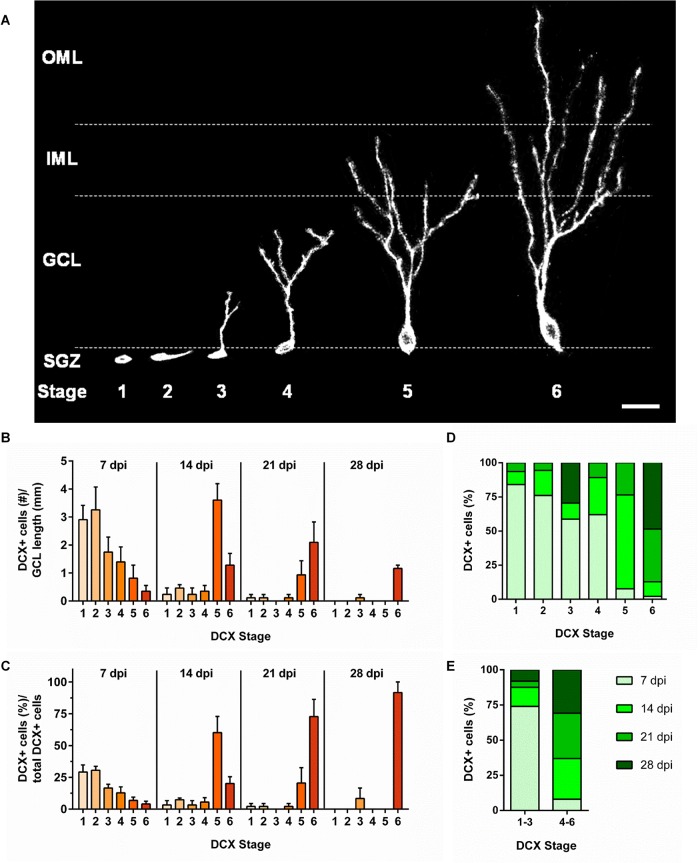
Structural maturation of DCX-expressing newborn DGCs is correlated with cell age.(A) DCX+ cells were categorized into six stages according to the degree of their structural maturation. Cells were considered to be in stage 1 when the soma was positioned in the subgranular zone (SGZ) and no dendritic processes were visible; stage 2 when the cell displayed short processes that were located within the SGZ; stage 3 when the principal dendritic process projected into the inner half of the granule cell layer (GCL); stage 4 when the leading dendrite reached the outer half of the GCL; stage 5 when the leading dendrite extended into the inner molecular layer (IML); and stage 6 when the leading dendrite reached the outer molecular layer (OML). (B, C) Staging of newborn DCX+ DGCs at different time points revealed a marked shift in stage distribution according to cell age. At 7 dpi, the majority of newborn DCX+ DGCs were classified as stage 1 or 2, while at 14 dpi, the majority of cells were classified as stage 5 or 6. At 28 dpi, about 92% of the DCX+ cells were classified as stage 6, but a small percentage of DCX+ cells were classified as stage 3. (D, E) The distribution of DCX+ cell ages according to each stage illustrates the prevalence of DCX stages 1–4 at 7 dpi and DCX stages 5–6 at 14 to 28 dpi. No BrdU/DCX+ DGCs were observed after 28 dpi. Notably, DCX+ cells of stages 1–6 co-existed at the same time points (7–21 dpi), suggesting a variability in the maturation time course of individual neurons. All data were obtained from 3 animals (n = 3) per group, and 3 sections per animal. Error bars represent SEM. Scale bar in (A): 20μm.